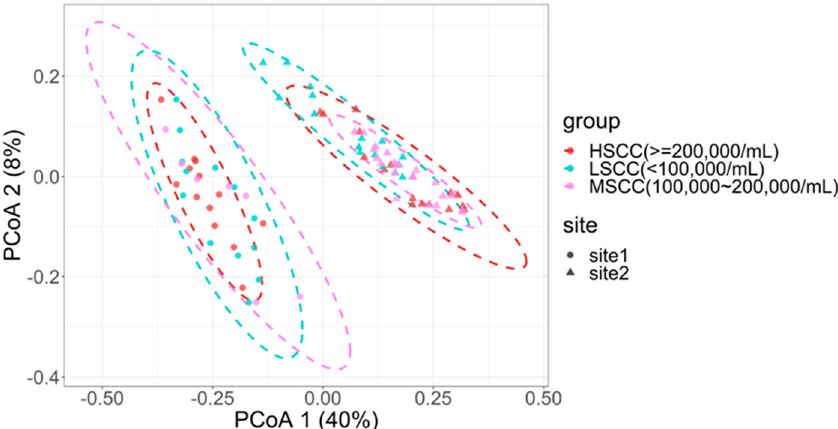
Figure 3. Principal coordinate analysis (PCoA) of Bray − Curtis distances among all milk samples. Table 1. Effect of different factors on milk microbial composition examined through Bray–Curtis distance-based redundancy analysis by